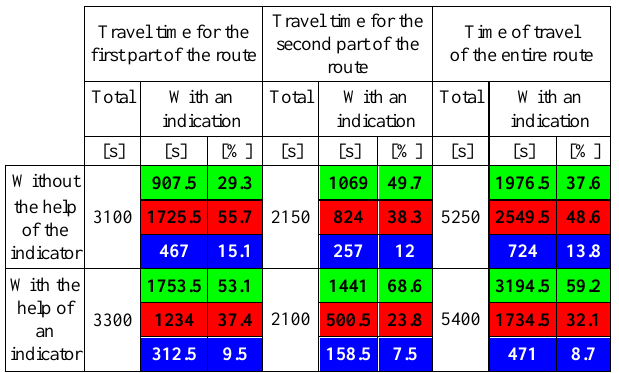
Table 1. Route times for the cases shown in Fig. 14, divided into the first and the second part of the route and with the percentage share of each indication